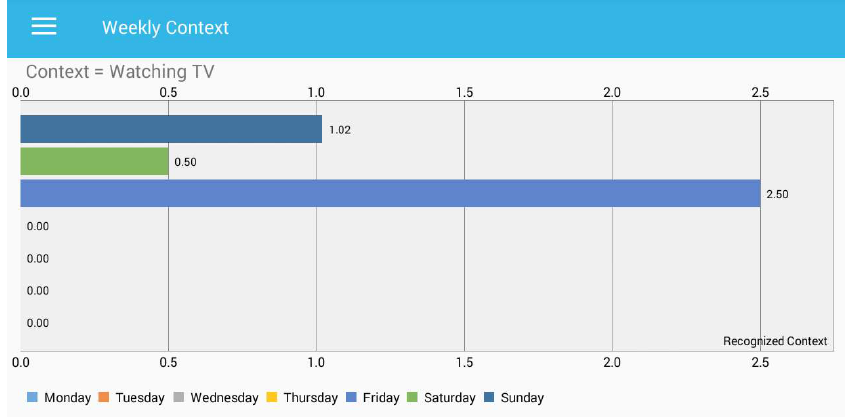
Figure 13. Total time spent during a week for “watching